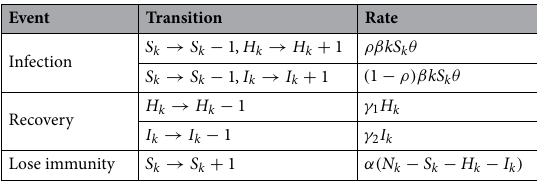
Table 1. List of transition rates.